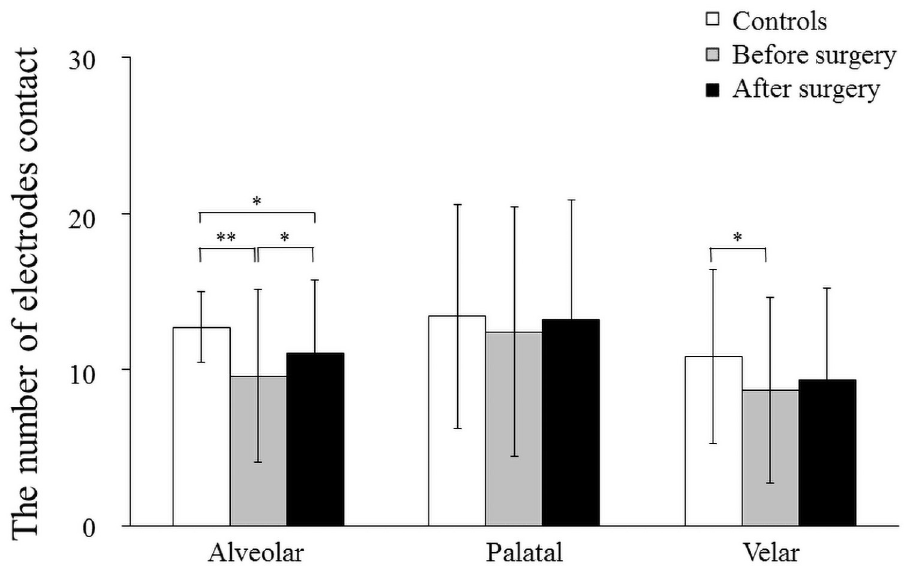
Fig 4. Mean and standard deviation in the number of electrodes contact of alveolar, palatal and velar part in the controls, patients before surgery, and after surgery. 0.3 seconds before complete tongue-palatal contact ( � : p < 0.05, �� : p <